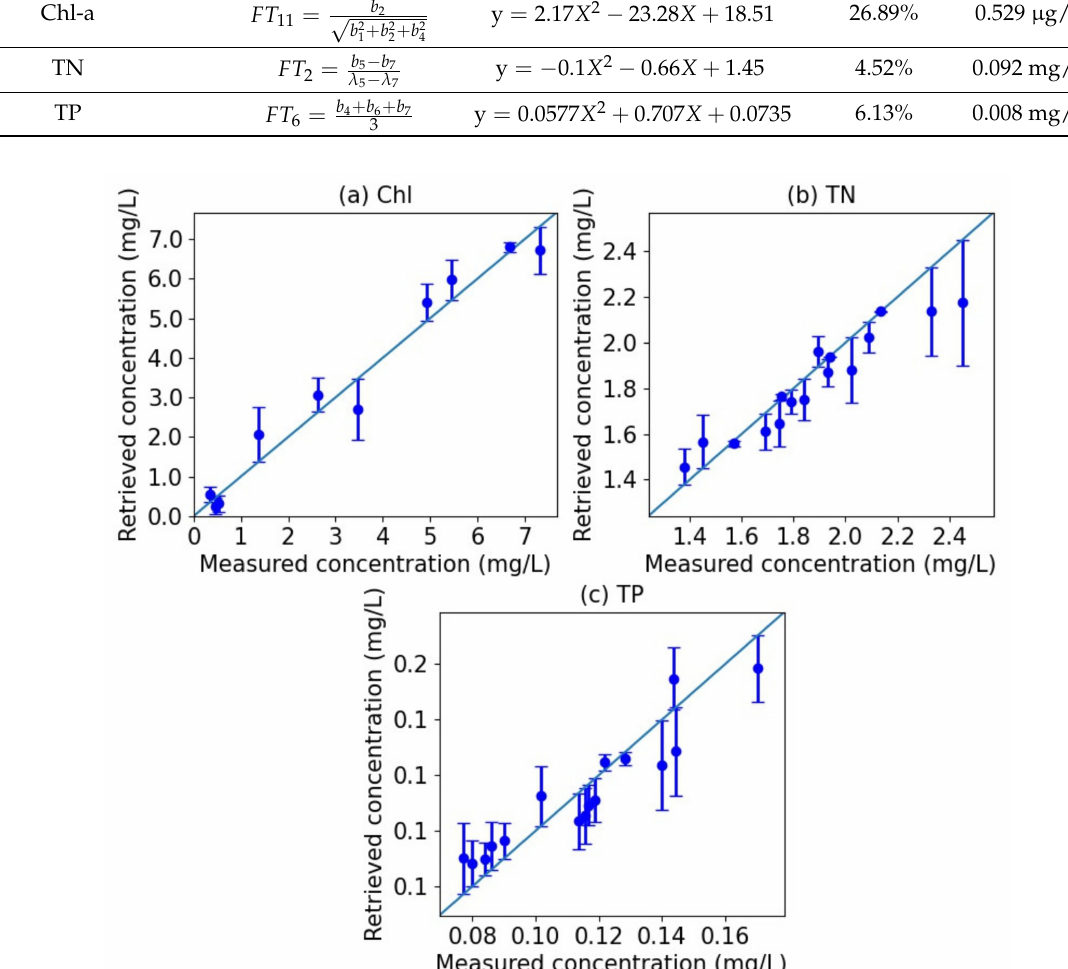
Figure 4. Comparison of retrieved concentrations and the measured concentrations of ( a ) Chl-a, ( b ) TN, and ( c ) TP,